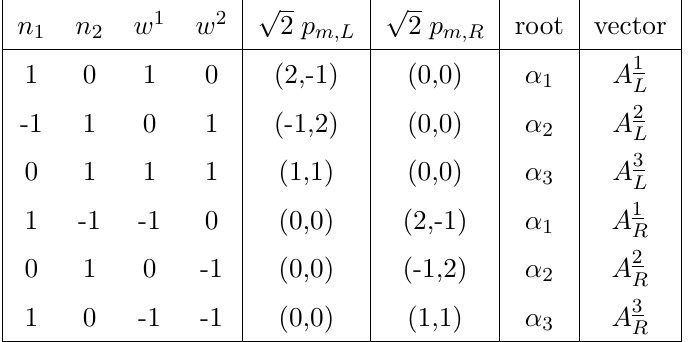
Table 2 . Massless vectors with momentum and winding at the SU(3) L (cid:2) SU(3) R enhancement